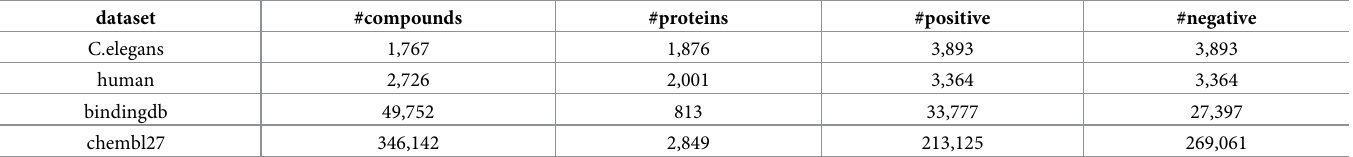
Table 1. Summary of the experimental datasets.